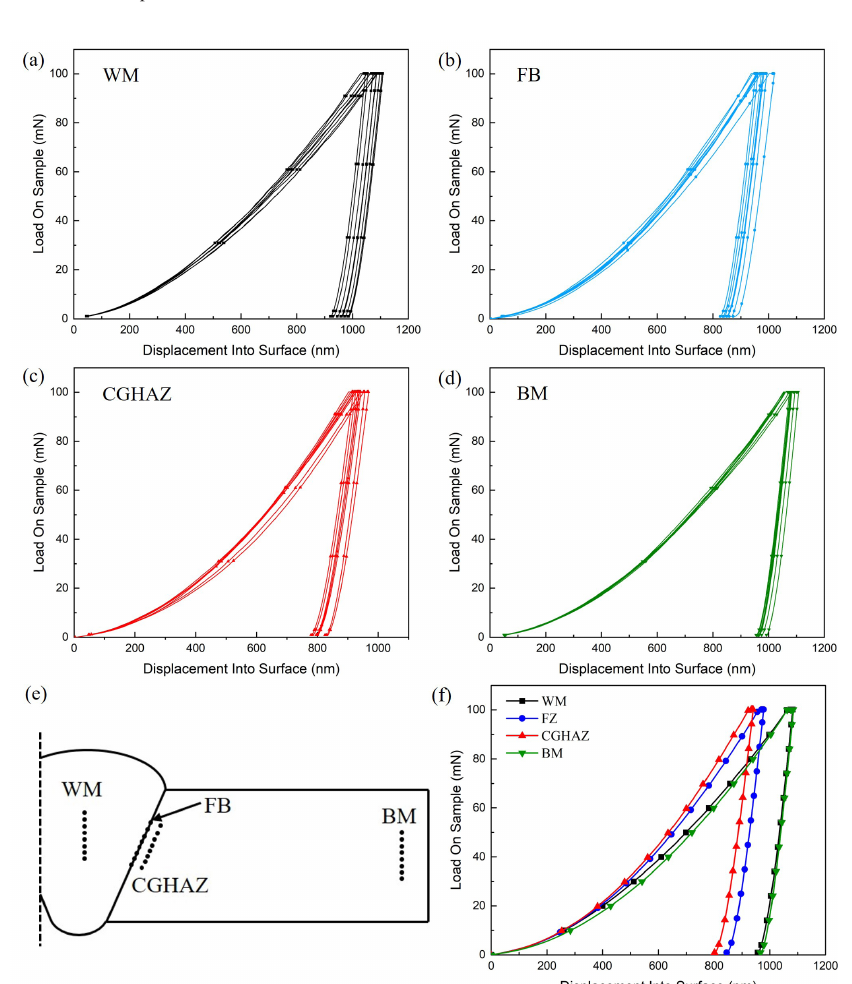
Figure 8. P-h curve of each micro